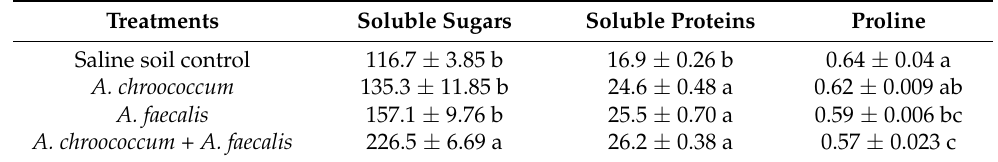
Table 2. Organic solutes contents (mg g − 1 DW) in canola plant inoculated with Azotobacter chroococ- cum, Alcaligenes faecalis, and their co-inoculation under salinity-stress conditions. Bars show means of three independent replications (n = 3) ± standard error. Means with the same letter are not significantly different at p < 0.05. DW: dry weight.